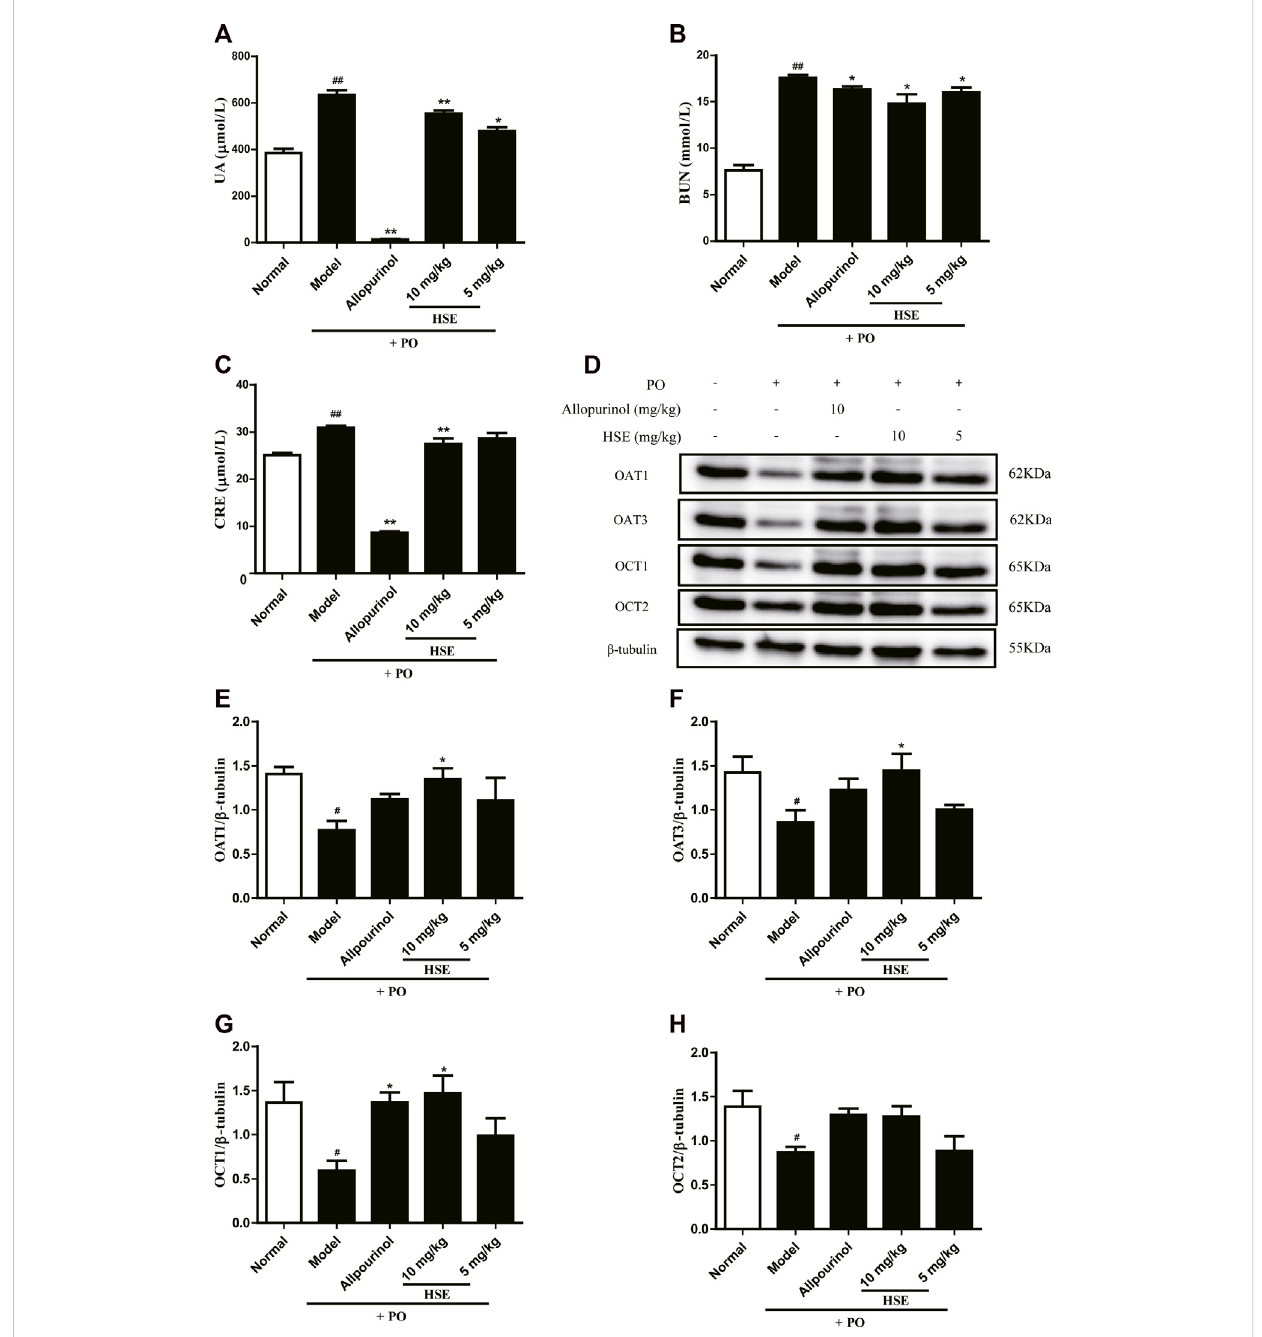
Effects of hesperetin (HSE) on serum parameters and proteinlevelsin mice with hyperuricemia induced by potassium oxonate. (A) Uricacid (UA) (B) Blood urea nitrogen (BUN) (C) Serum creatinine (CRE). Protein expression of OAT1 (E) , OAT3 (F) , OCT1 (G) , OCT2 (H) , and β -tubulin were determined via Western blotting quanti fi ed with ImageJ. The dose of allopurinol was 10 mg/kg in vivo experiments. These data were from three separate experiments and expressed as the mean ± SEM. # p < 0.05 and ## p < 0.01 versus the normal group; * p < 0.05 and ** p < 0.01 versus the model group. HSE, hesperetin; UA, uric acid; BUN, blood urea nitrogen; CRE, serum creatinine; PO, potassium oxonate; XOD, xanthine oxidase; OAT1, organic anion transporter 1; OAT3, organic anion transporter 3; OCT1, organic cationic transporters 1; OCT2, organic cationic transporters